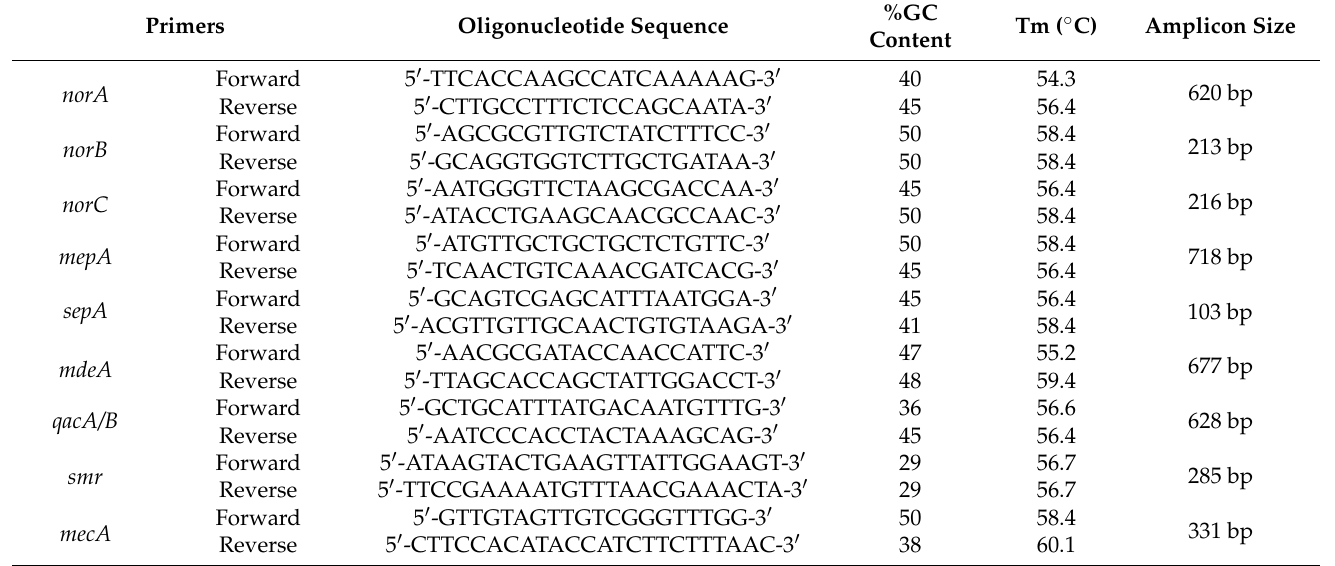
Table 1. List of primers with detailed information for the identification of different efflux pump